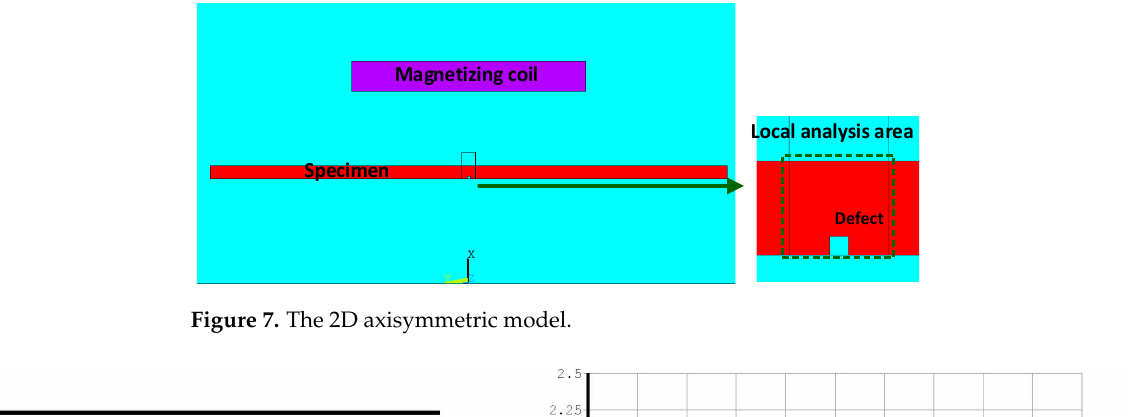
Figure 6. Schematic diagram of magnetic field perturbation of defects of different buried depths.